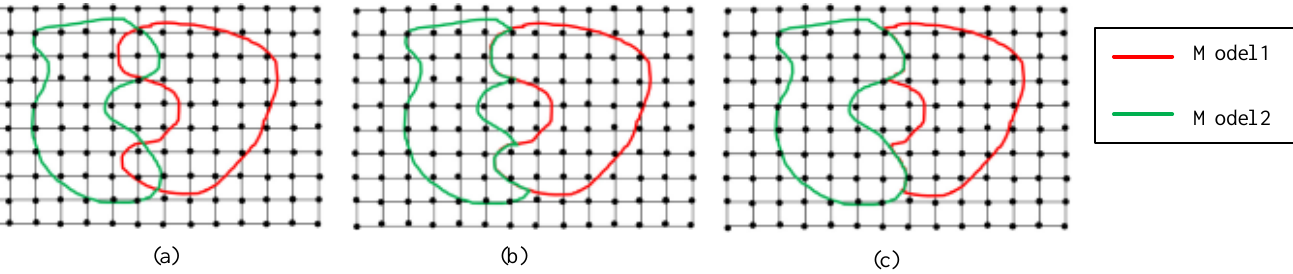
Figure 4. Set the labels of voxel points. ( a ) Labels of the general voxel points. ( b ) Labels of the ambiguous voxel points.